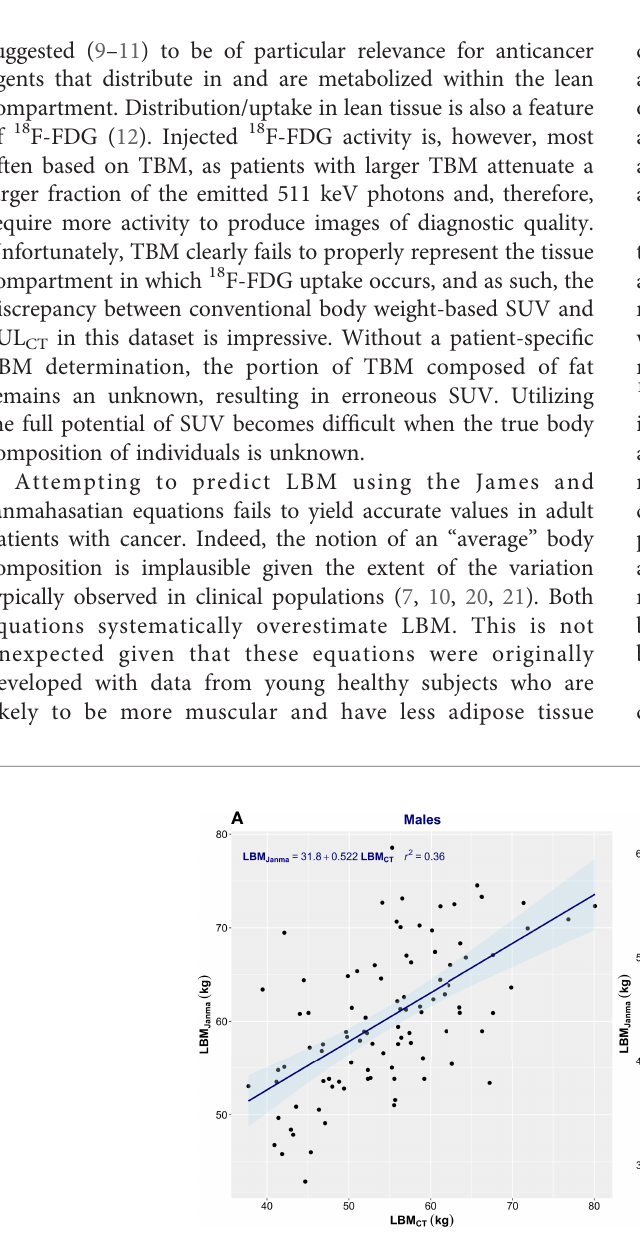
FIGURE 4 | Scatter plot of CT-de fi ned lean body mass (LBM CT ) vs. that estimated by Janmahasatian ’ s equation (LBM Janma ). Men (A) and women (B) . The linear regression equation is provided in the top left of each graph, and it is plotted in blue. The shaded light-blue area represents the 95% con fi dence interval, and r 2 is the square of the Pearson correlation coef fi cient for LBM CT vs. LBM Janma